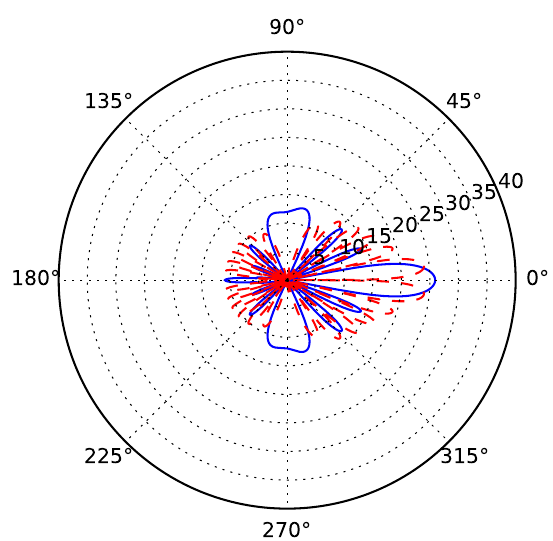
Figure 11. The sum and difference beam patterns for an amplitude comparison monopulse receiver, units are in dBi.